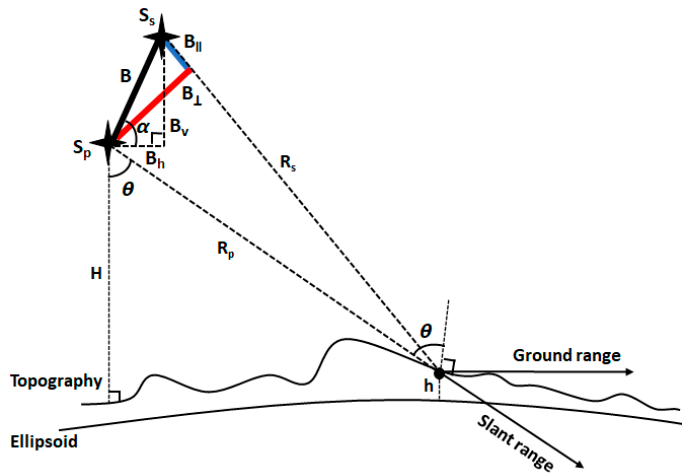
Figure 4. The geometry of an InSAR system.